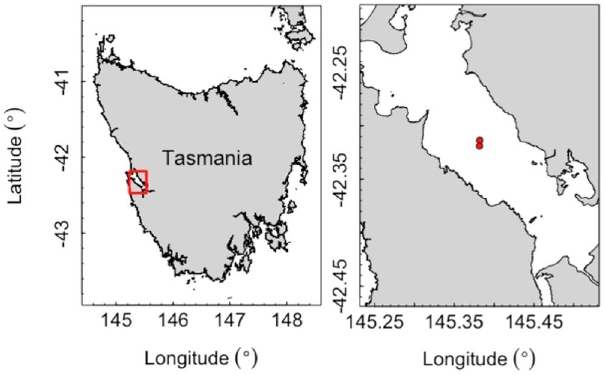
Figure 5. Map of experimental salmon cage locations in Macquarie Harbour on the west coast of Tasmania. Red rectangle in full-scale map of Tasmania on the left indicates extent of detailed map of Macquarie Harbour on the right. Red dots indicate experimental cage locations. Map was created in R version 3.3.1 44 , using the ‘PBSmapping’ package version 2.69.76 48